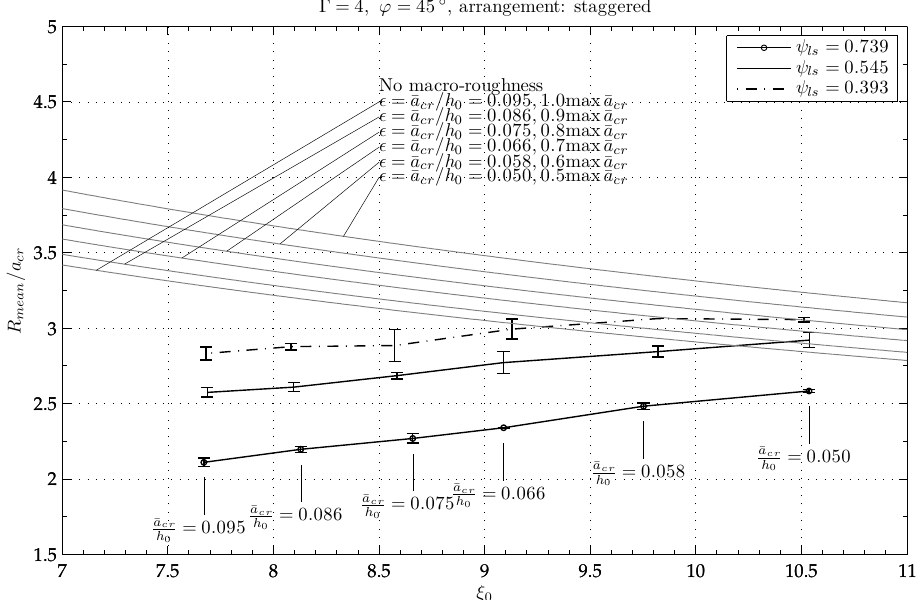
Fig. 14. The relative wave run-up ( R mean /a cr ) as a function of the surf similarity parameter ( ξ 0 ), 0 = 4. The experimental data are plotted according to the individual long-shore obstruction ratio. The error bars indicate the variation of the number of macro-roughness element rows. The grey parallel graphs indicate the relative run-up without the interaction with macro-roughness. The non-linearity of the applied waves is indicated as text which always refers to all error bars in the vertical